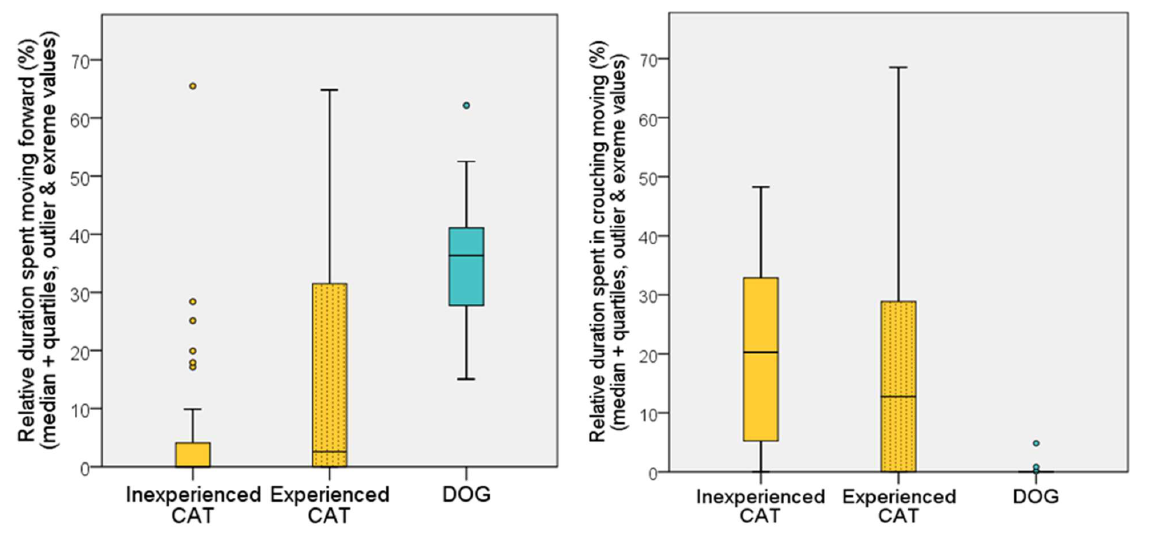
Figure 7. Relative duration (%) of time spent in different movements (forward—crouching) by dogs and cats during the first 5 min of the habituation test on the first occasion. Dogs spent more time close to the owner than cats (U = 240; p < 0.001), while cats spent more time close to their box than dogs were close to their blanket (U = 179; p < 0.001) (Figure 8).